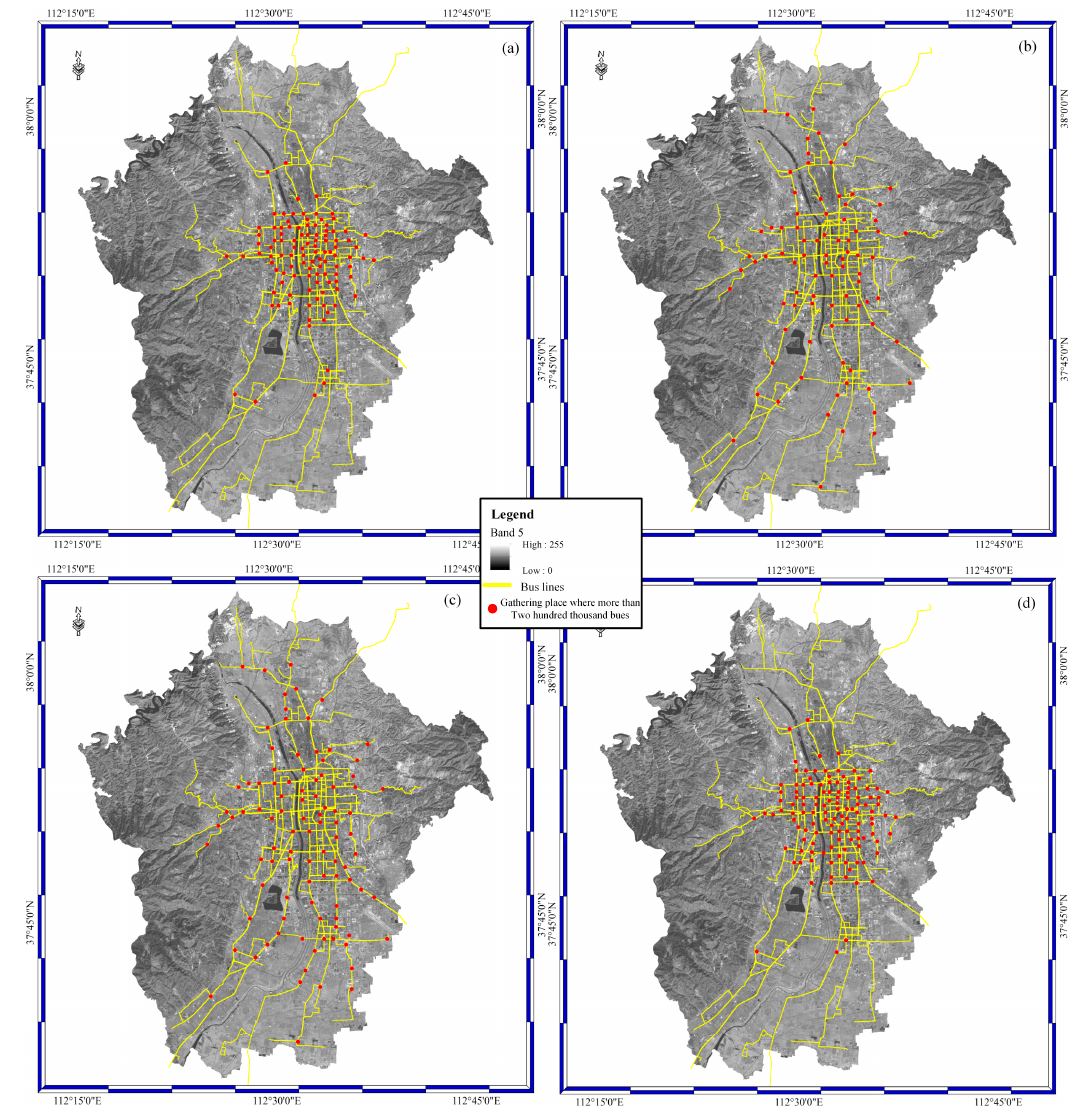
Figure 6. Buses distribution map of Taiyuan city: ( a ) from 7:30 a.m. to 9:00 a.m.; ( b ) from 11:00 a.m. to 12:00 a.m.; ( c ) from 12:30 p.m. to 2:00 p.m.; and ( d ) from 7:30 p.m. to 9:00 p.m.